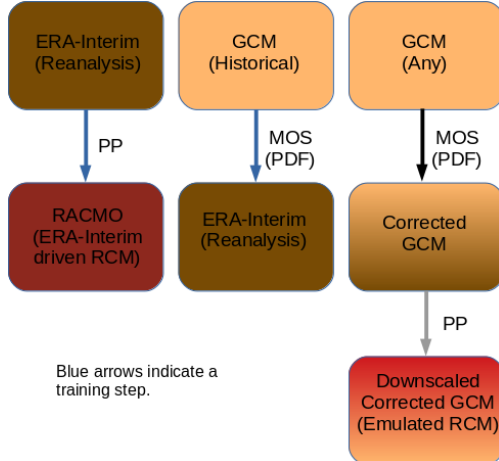
Figure 1. The statistical downscaling can be generally decomposed into three successive steps, including (1) the association of the re- analysis with the regional climate model by a perfect prog (PP; Ma- raun and Widmann, 2018); (2) a correction of the historical GCM to make it unbiased compared to the reanalysis using model output statistics; and (3) the successive correction of the GCM followed by the application of the perfect prog, giving way to an emulated RCM estimation using the corrected GCM. Each uniform color cor- responds to a model (GCM, reanalysis, RCM). The colors are mixed with a gradient for each operation including more than one